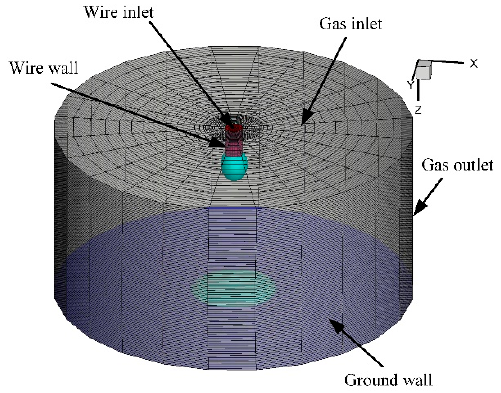
Figure 1. Schematic diagram of the 3D calculation domain.